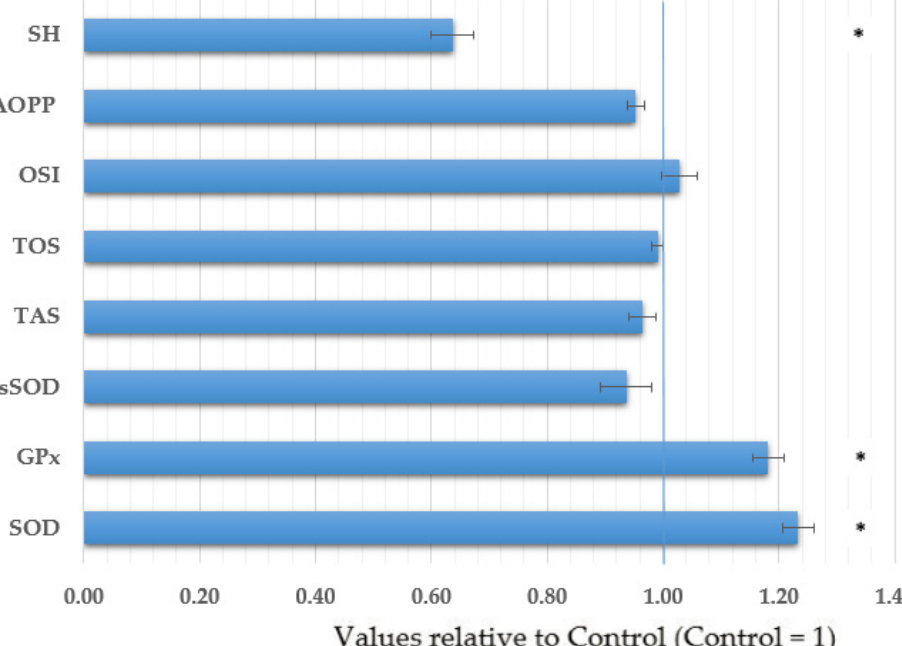
Figure 1. Comparison of oxidative stress parameters between men with prostate cancer and healthy men (control). The results are presented relative to control values (mean +/ − SE). Relative values were calculated for each parameter separately by dividing the value of each patient by the mean value of the control group. Obtained mean and SE values are presented. * Significantly different